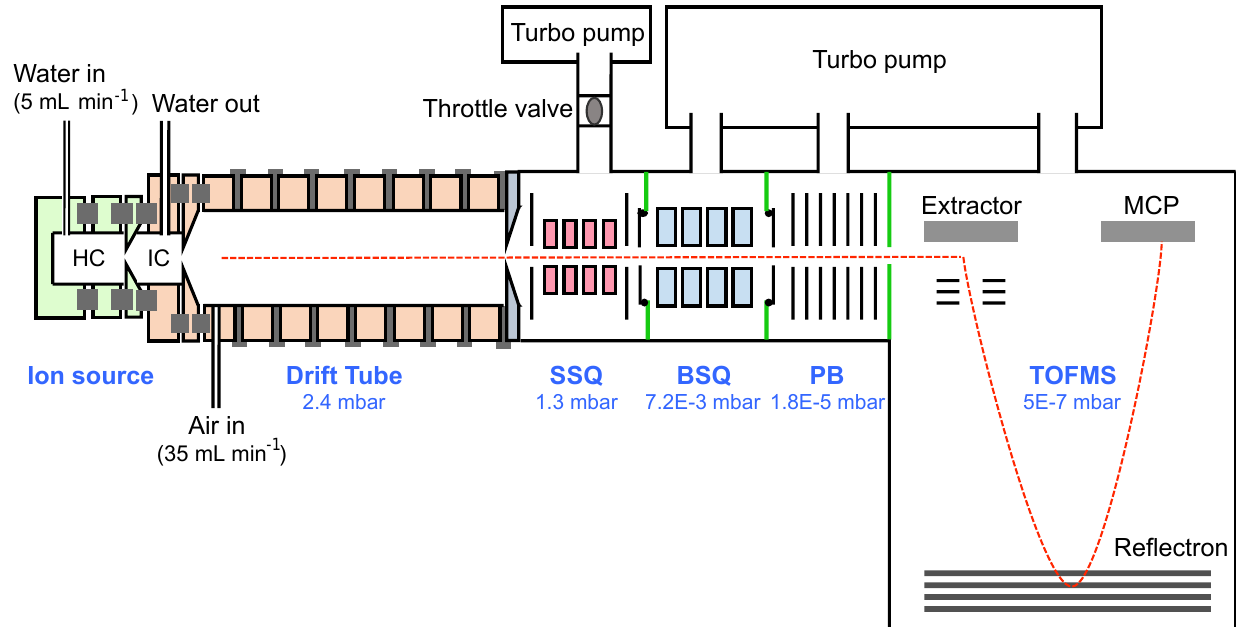
Figure 1. Schematic drawing of the H 3 O + ToF-CIMS. HC: hollow-cathode discharge; IC: intermediate chamber; SSQ: small segmented quadrupole; BSQ: big segmented quadrupole; PB: primary beam; MCP: microchannel plate